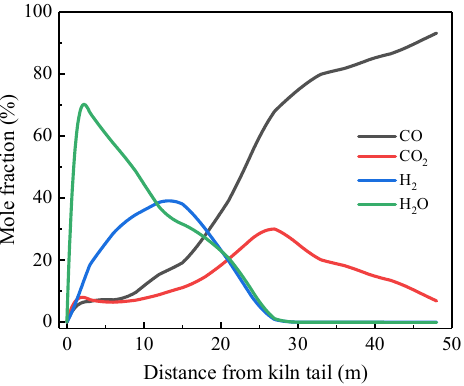
Figure 9. Average mole fraction of gas composition in the bed region along the axial section.